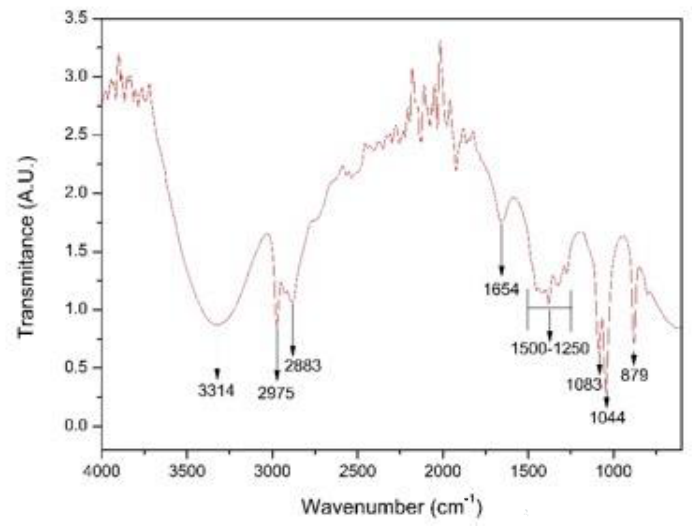
Figure 5. FTIR spectrum of the coriander extract ( Coriandrum sativum ).